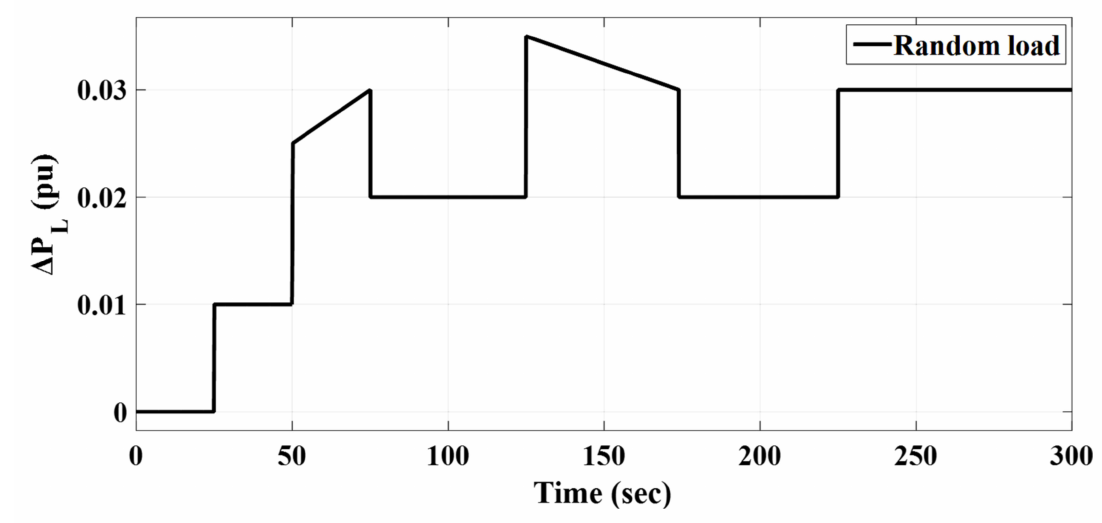
Figure 19. The form of the applied random load